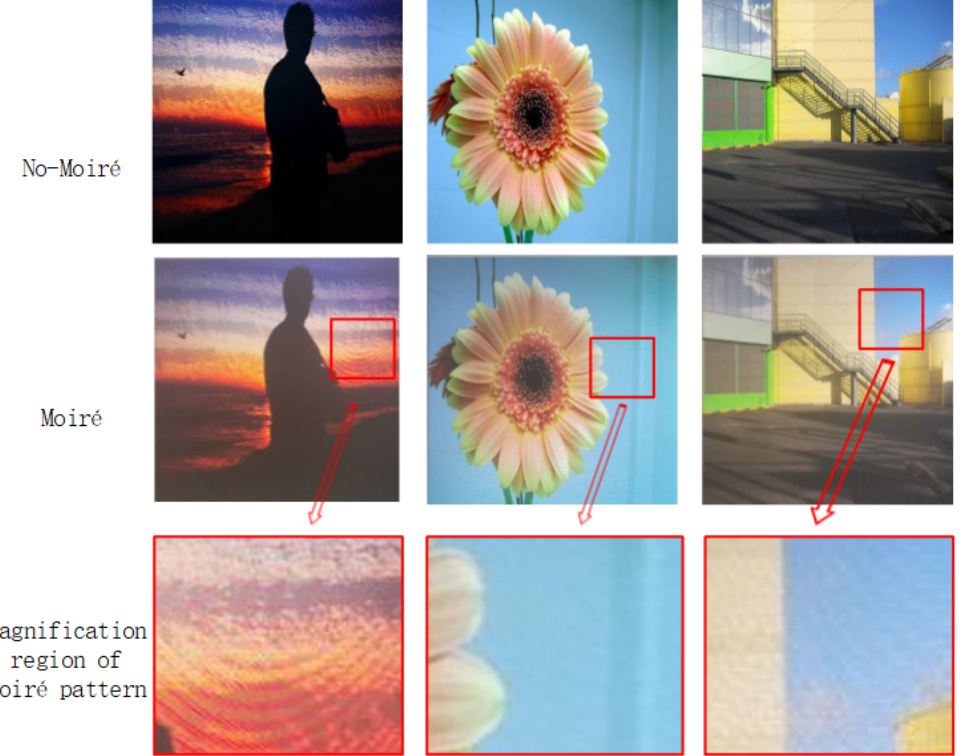
Figure 3. ( Row 1 ): Pure images. ( Row 2 ): Images with moiré pattern. ( Row 3 ): A region of the image with moiré pattern and its